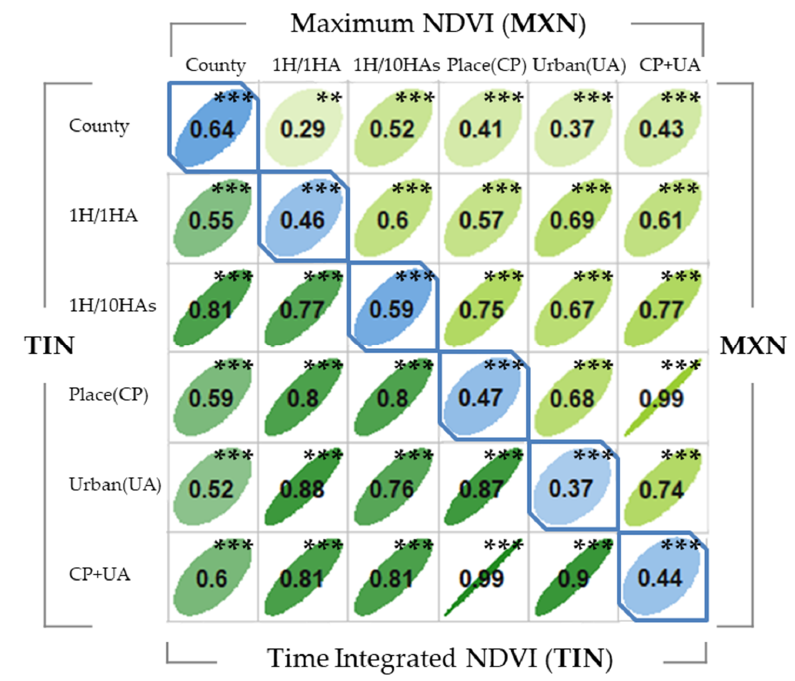
Figure 3. Correlation of each spatial boundary of maximum NDVI and time-integrated NDVI in Illinois.